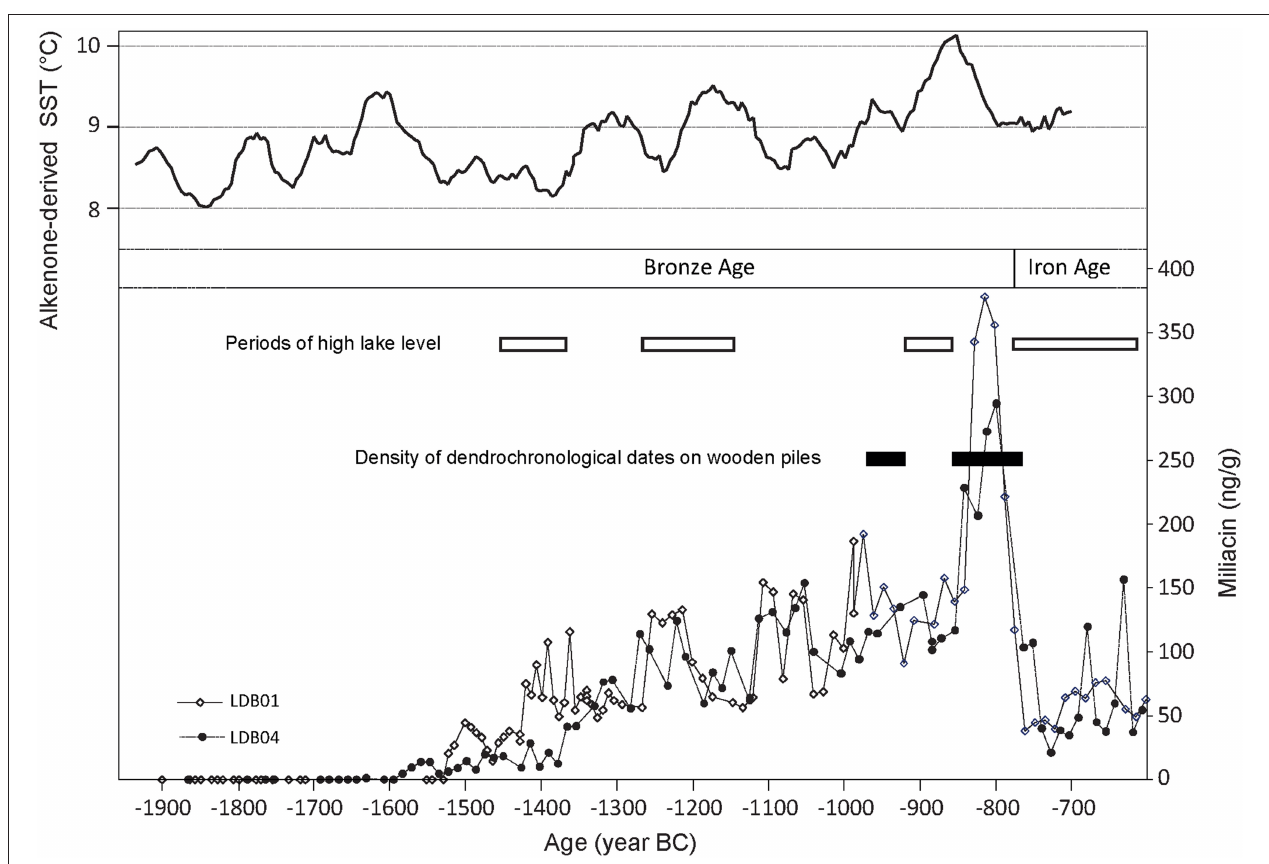
FIGURE 5 | Evolution of miliacin concentration in cores LDB01 and LDB04 from Lake le Bourget (Savoie, France). Cores LDB01 and LDB04 were collected in 2001 and 2004, respectively, at 4 km distance and benefit from independent age models (Arnaud et al., 2005; Debret et al., 2010). Miliacin concentrations are compared to Sea Surface Temperatures as reconstructed from alkenones paleothermometry north of Iceland (Sicre et al., 2008b), to the density of dendrochronological dates measured on wooden piles on various palafittic sites around Lake le Bourget (Billaud, 2012) and to high levels of Lake le Bourget as reconstructed by Magny